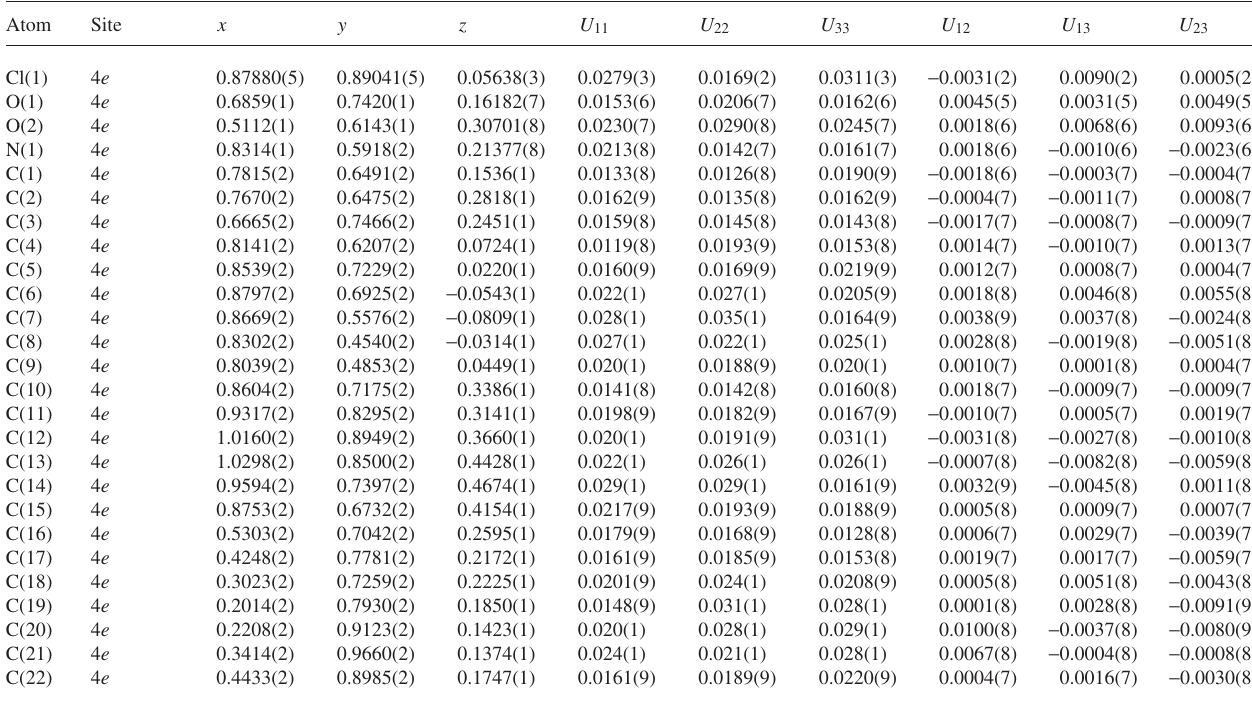
Table 3. Atomic coordinates and displacement parameters (in Å 2 ) .